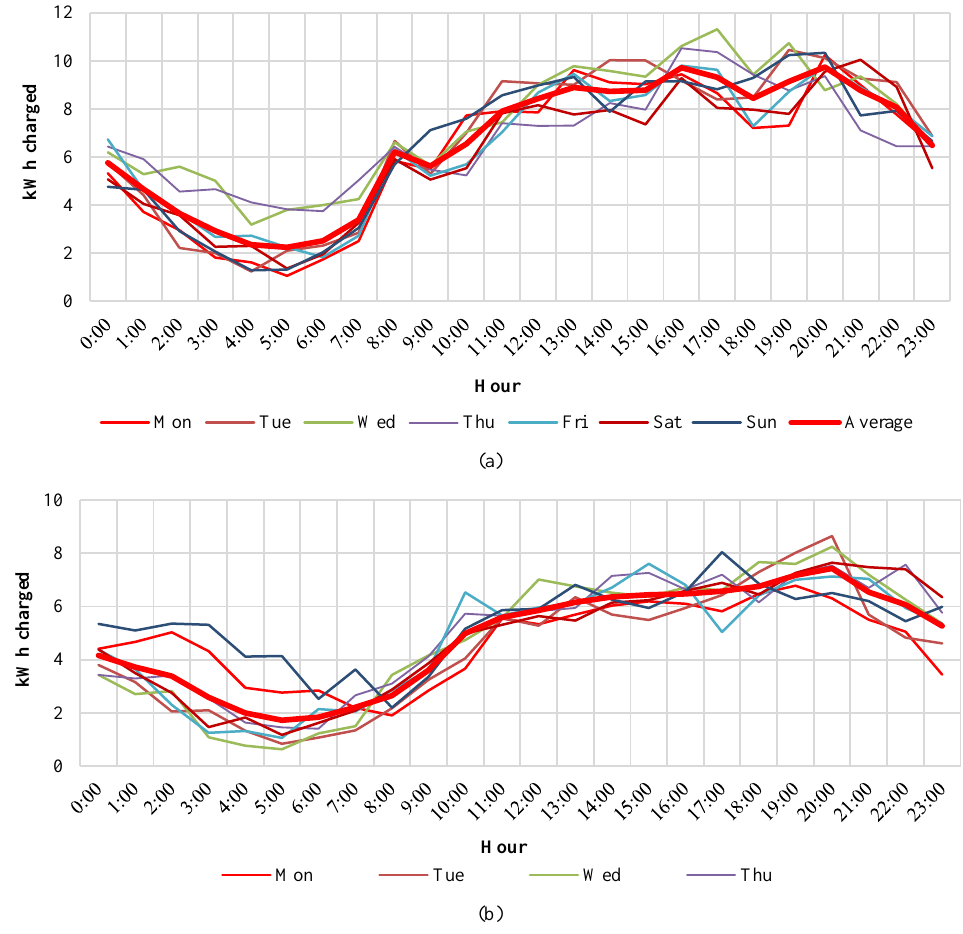
Fig. 6. Average charged energy during a day: (a) Bauska street; (b) Eizensteina street charging